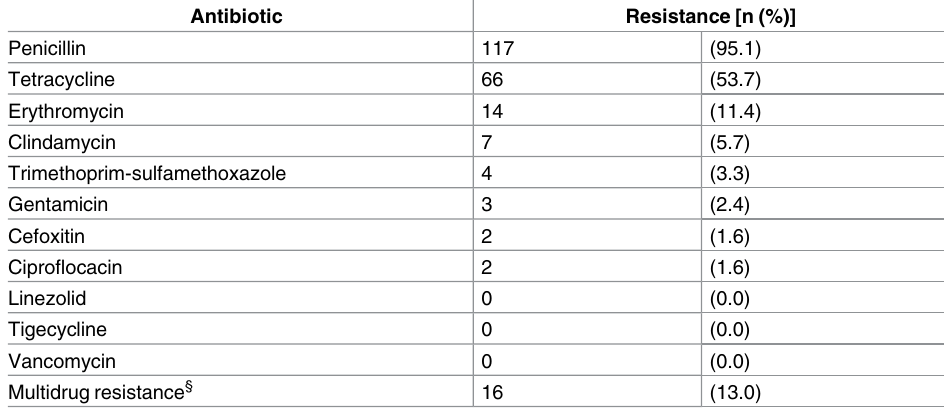
Table 3. Antibiotic resistance profile of nasal Staphylococcus aureus isolates (n =